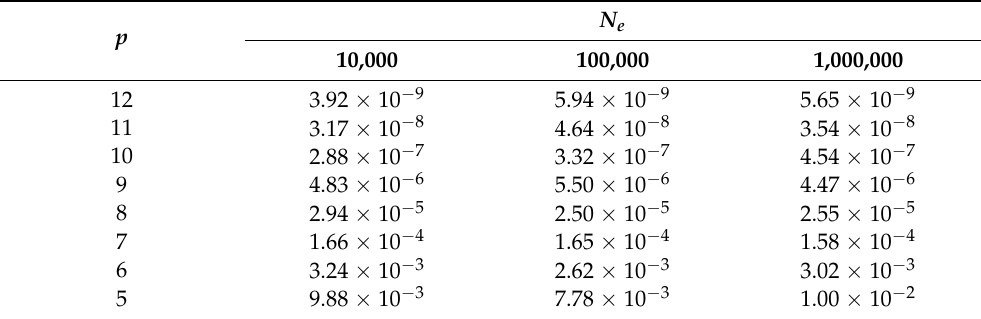
Table 2. The max residual of the RBF interpolant (triharmonic spline) using the fast multipole method with different expansion orders (the number of source points N s is 10,000). N e is the number of evaluation